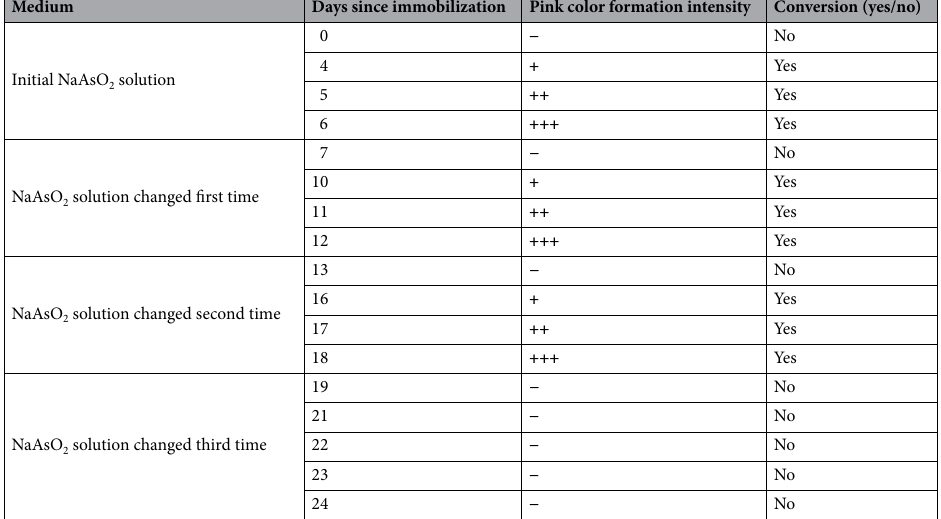
Table 1. Day-wise test results of phenotypic detection of arsenite oxidation by KMnO 4 for immobilized A. xylosoxidans BHW-15 isolate. Here, −, +, ++, +++ indicate no color formation, low intensity, moderate intensity, strong intensity respectively.